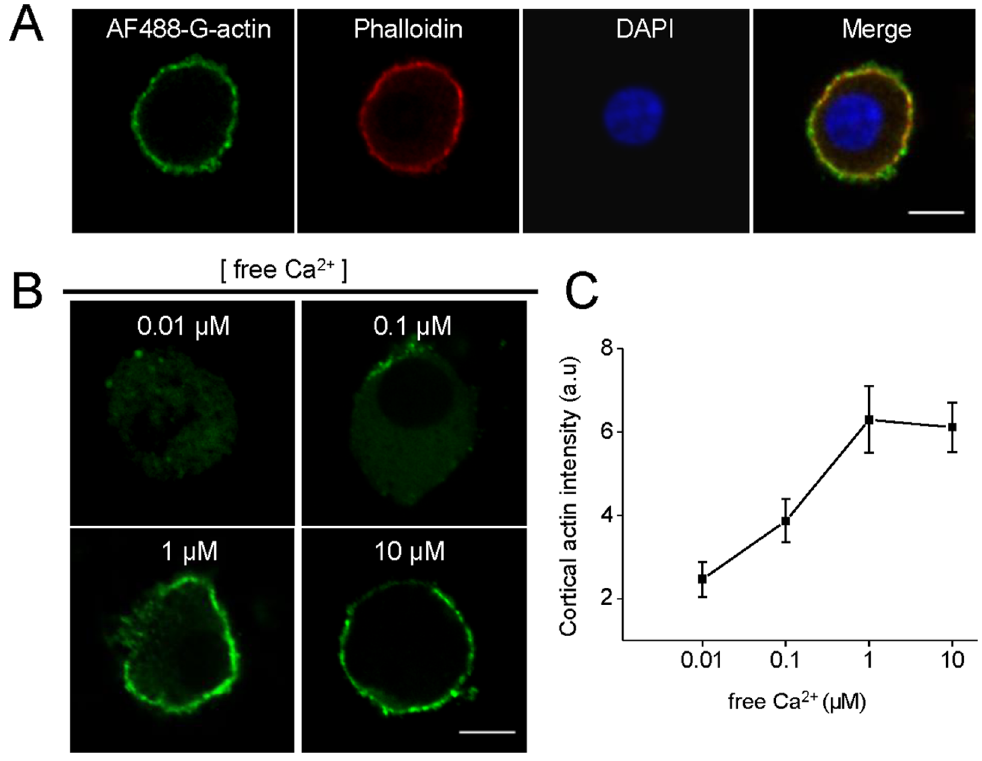
Figure 4. Calcium-dependent cortical actin polymerization in permeabilized chromaffin cells. Cultured chromaffin cells were permeabilized in buffer KGEP (mM: 139 K + -glutamate, 20 Pipes, 5 EGTA, 2 ATP-Mg and 0.01 free calcium, pH 6.6) during 6 minutes with 20 m M digitonin in the presence of 0.3 m M Alexa-Fluor488-G-actin conjugate (AF488-G-actin), fixed and visualized by confocal microscopy. A: Total F-actin was stained using 1 m M phalloidin-rodhamine B (red) and nuclei were stained with 5 m g/ml DAPI (blue). Note that newly synthesized actin was incorporated into pre-existing cortical filaments. B–C: The new formation of cortical actin filaments was assessed by quantifying AF488-G-actin staining mean intensity at the cell periphery in the presence of increasing free Ca 2 + concentrations. Note that maximal cortical actin polymerization was observed at a range of 1–10 m M of free Ca 2 + . Scale=10 m m. Data are means of cortical actin fluorescence intensity from at least 12 cells per each Ca 2 + concentration (12 cells for 0.01 m M Ca 2 + , 13 cells for 0.1 m M Ca 2 + , 15 cells for 1 m M Ca 2 + ,and 18 cells for 10 m M Ca 2 + ).